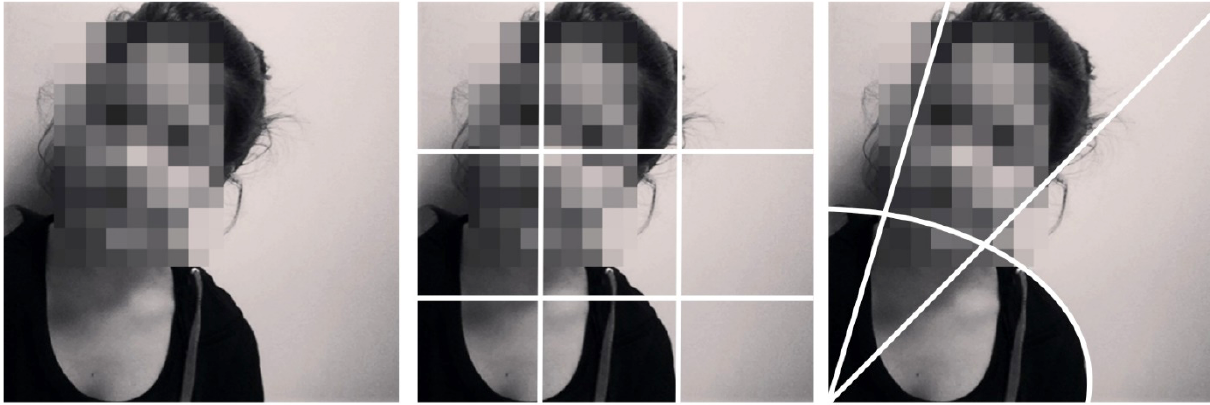
Figure 3. Compositional structure picture